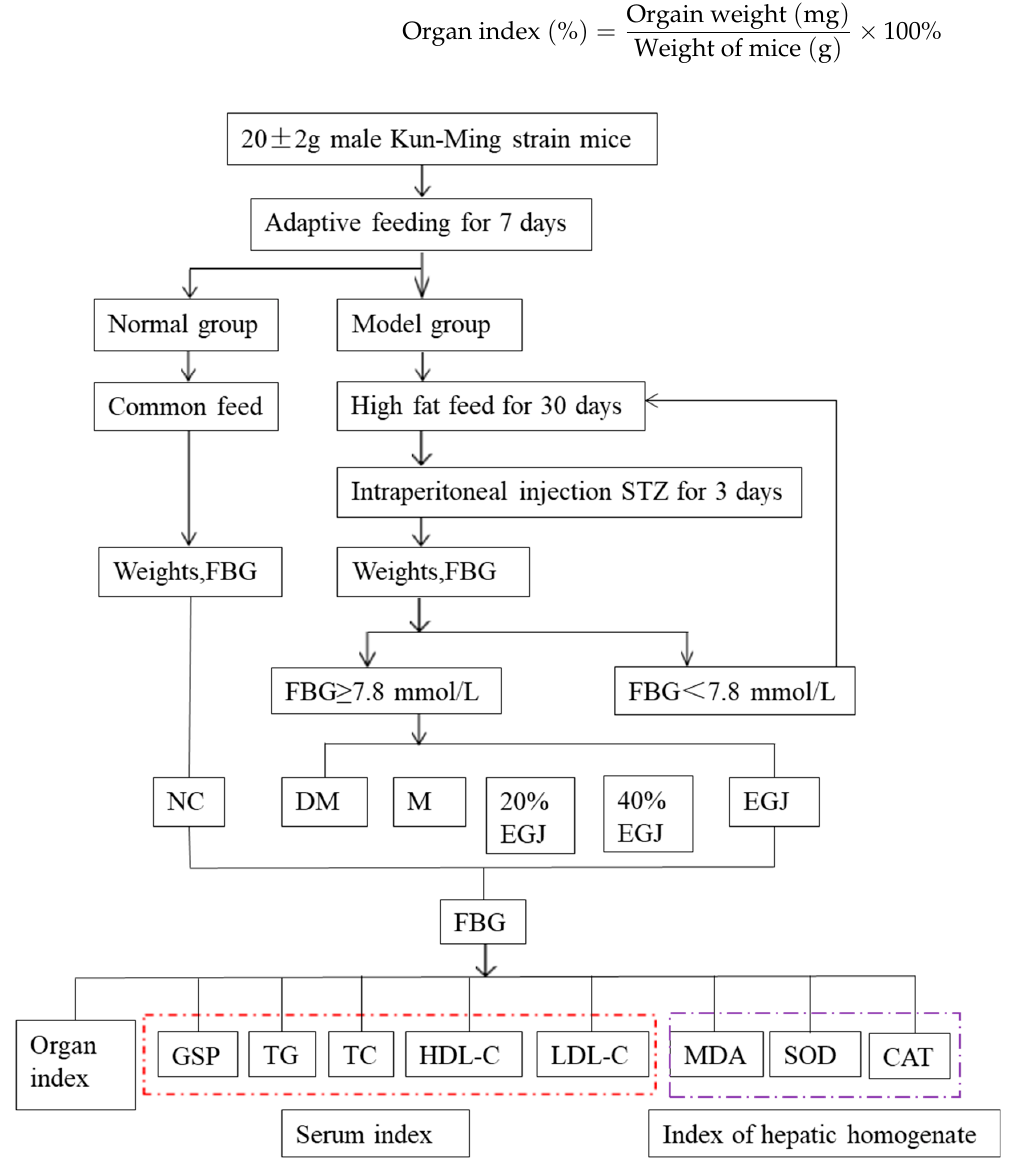
Scheme 1. Flow diagram of the animal